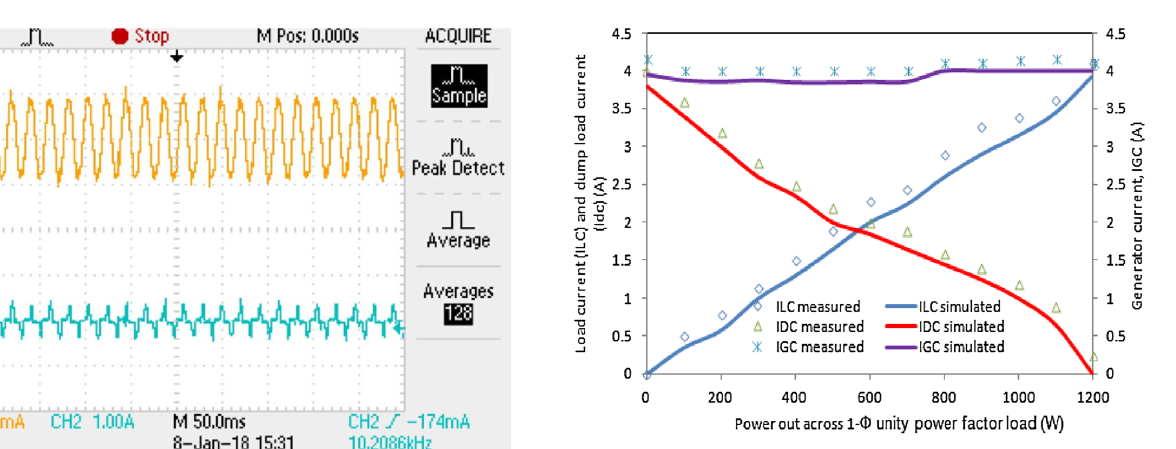
Fig. 12 Consumer current under varying consumer load under zero EGLC current